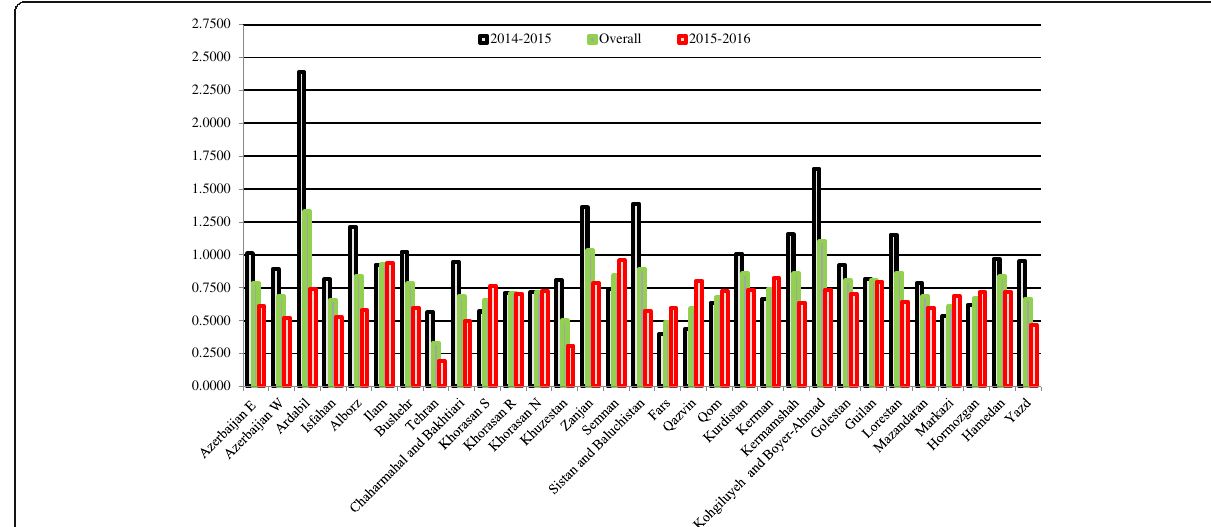
Fig. 6 The results of double-frontier MPI for the 31 Iranian